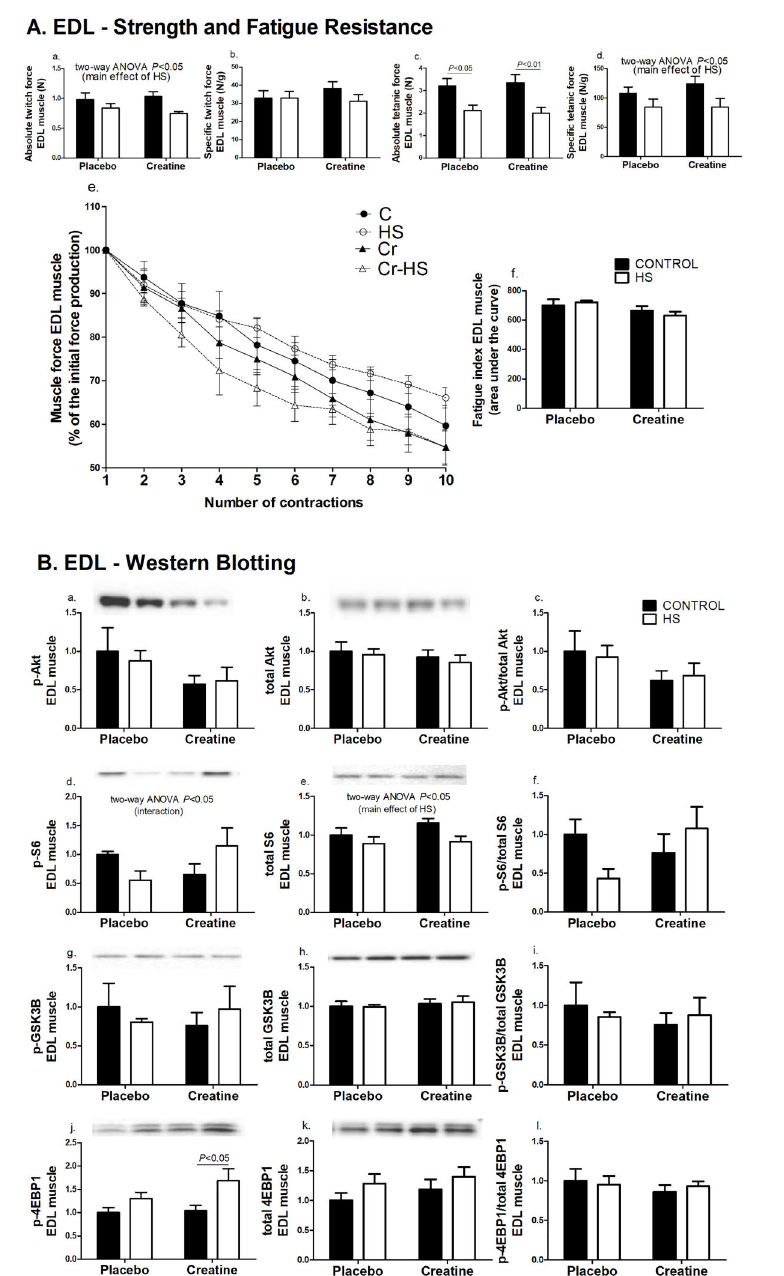
Figure 2. Strength, fatigue, and signaling pathways associated with protein synthesis in the extensor digitorum longus (EDL) muscle. A , Parameters of strength and fatigue in the EDL muscle. The results were compared using two-way ANOVA and Bonferroni post hoc test. Aa and Ad are P o 0.05 for C and Cr groups vs C-HS and Cr-HS groups (main effect of HS), using two-way ANOVA only (no statistical differences using the Bonferroni post hoc test). B , Markers of signaling pathways associated with protein synthesis in the EDL muscle. Data are reported as means ± SE on the basis of total protein loading as indicated by the Ponceau S measurements, n=6 – 8 animals. The results were compared using two-way ANOVA and Bonferroni post hoc test. Bd is P o 0.05 for an interaction between the effects of HS and creatine supplementation, using two-way ANOVA only (no statistical differences using the Bonferroni post hoc test). Be is P o 0.05 for C and Cr groups vs C-HS and Cr-HS groups (main effect of HS), using two-way ANOVA only (no statistical differences using the Bonferroni post-hoc test). C: control group; HS: hindlimb suspension group; Cr: creatine supplemented group; Cr-HS: creatine supplemented and hindlimb suspension